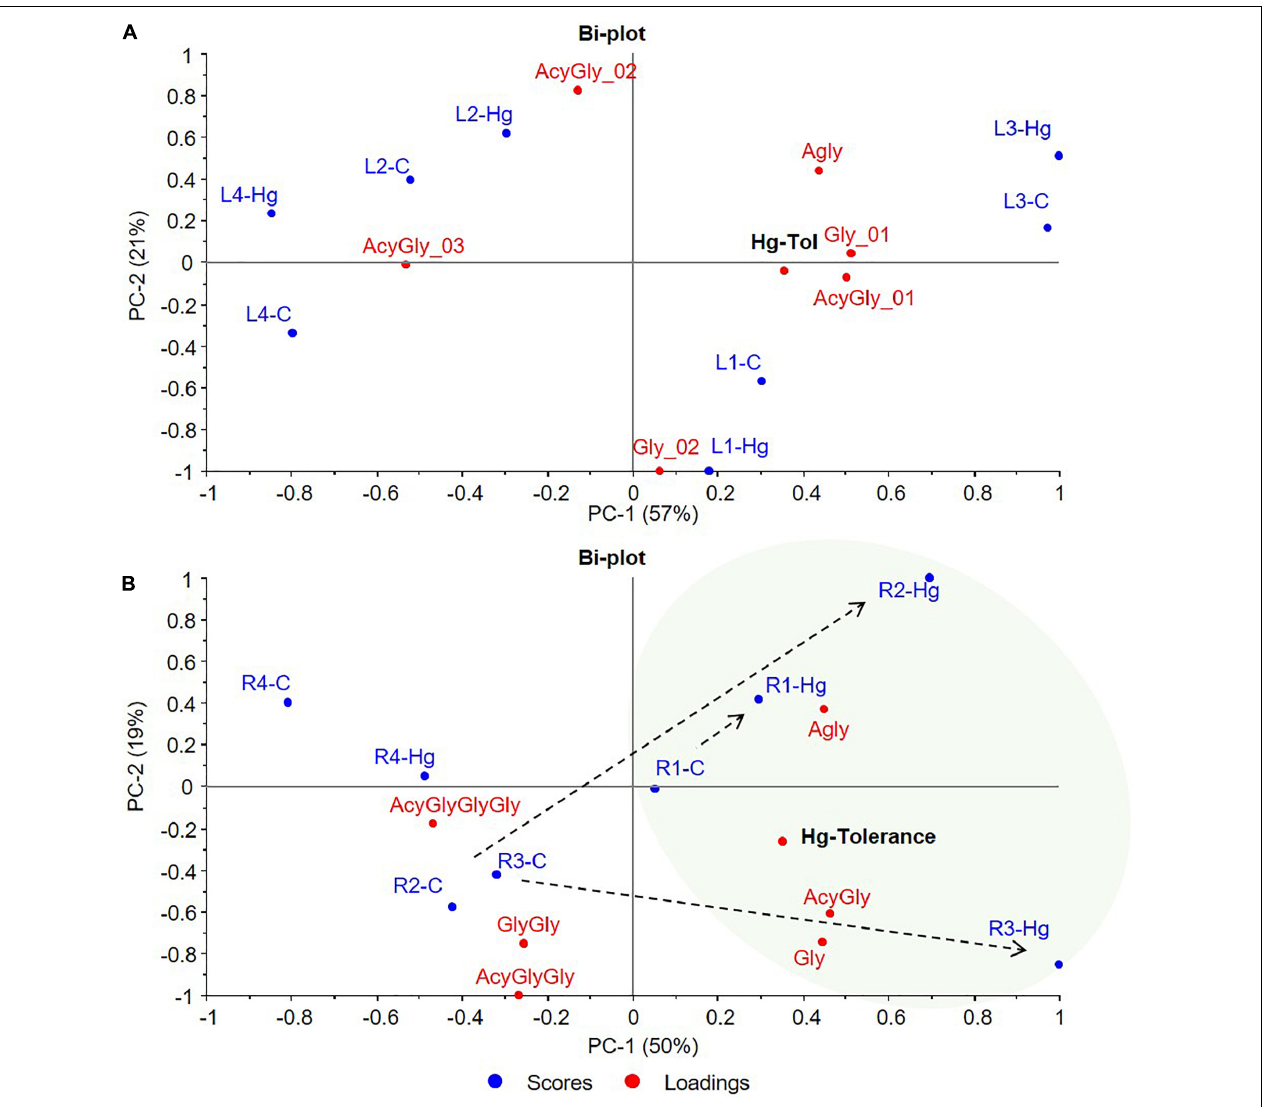
FIGURE 8 | PCA bi-plots of control (C, blue) and Hg-treated varieties (Hg, red) of Medicago truncatula, based on the flavonoids glycosylation degree. (A) Leaves and (B) Roots. Agly, aglycone; Gly, monoglycosylated; GlyGly, diglycosylated; GlyGlyGly, triglycosylated; and Acy,